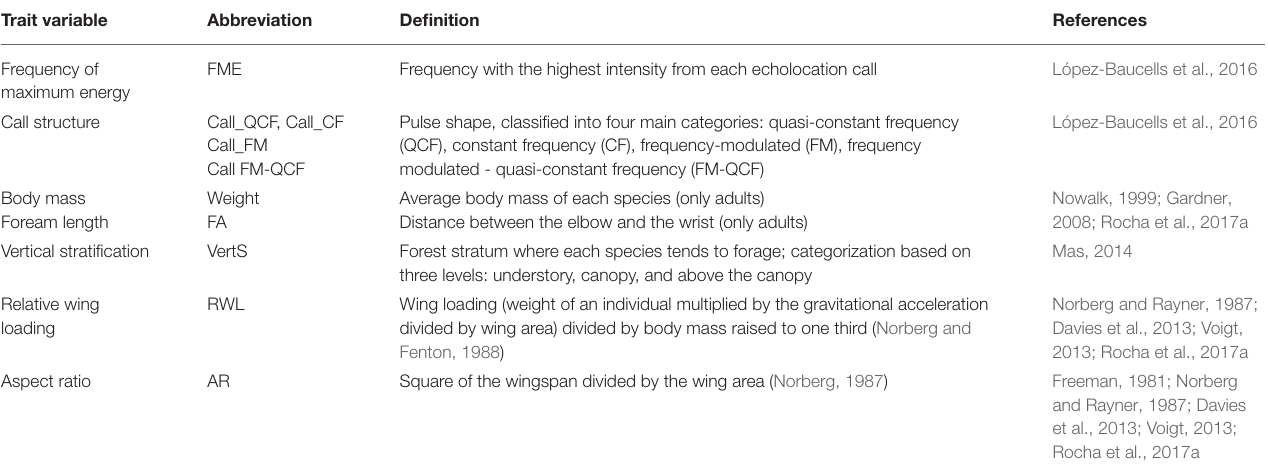
TABLE 1 | List of functional traits used as predictors of aerial-hawking insectivorous bat vulnerability to habitat fragmentation in the central Amazon. Trait